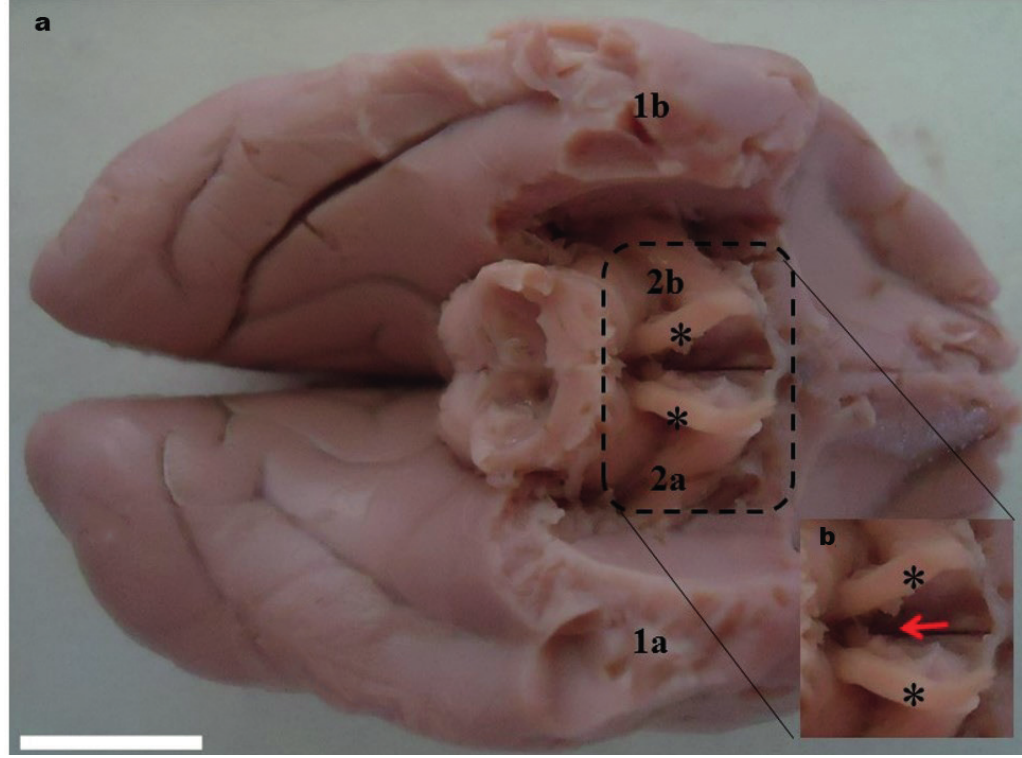
Figure 3 - Photomacrograph of the brain of Saimiri collinsi. (a) ventral view of the brain after the removal of a small portion of the left (1a) and right (1b) piriform lobes, as well as part of the cerebellum insertion for better visualization of the left cerebral peduncle (2a) and right (2b) and III pair of the cranial nerve (*). (b) enlarged view of cerebral peduncles and interpeduncular fossa (red arrow). Starting from the cerebral peduncles, the pair of cranial nerves III can be viewed (*). Scale bar: 1